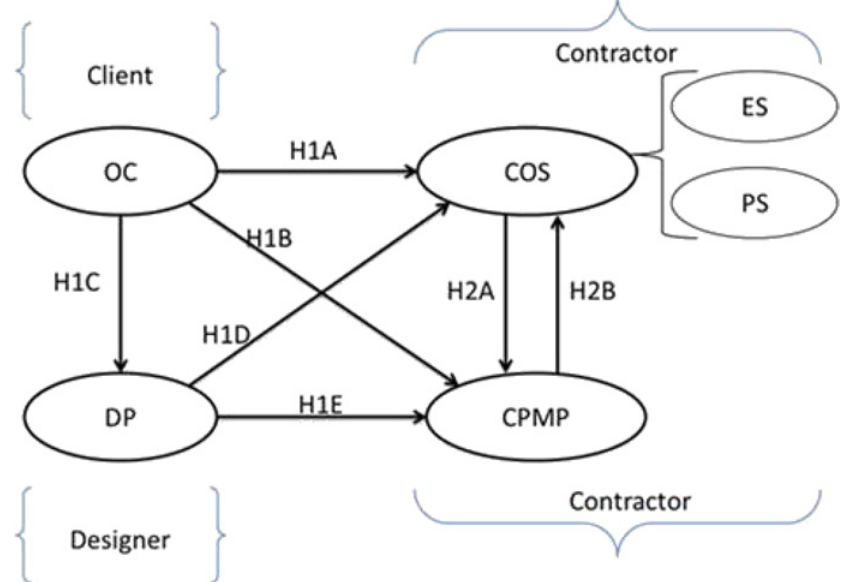
Figure 1 Conceptual model